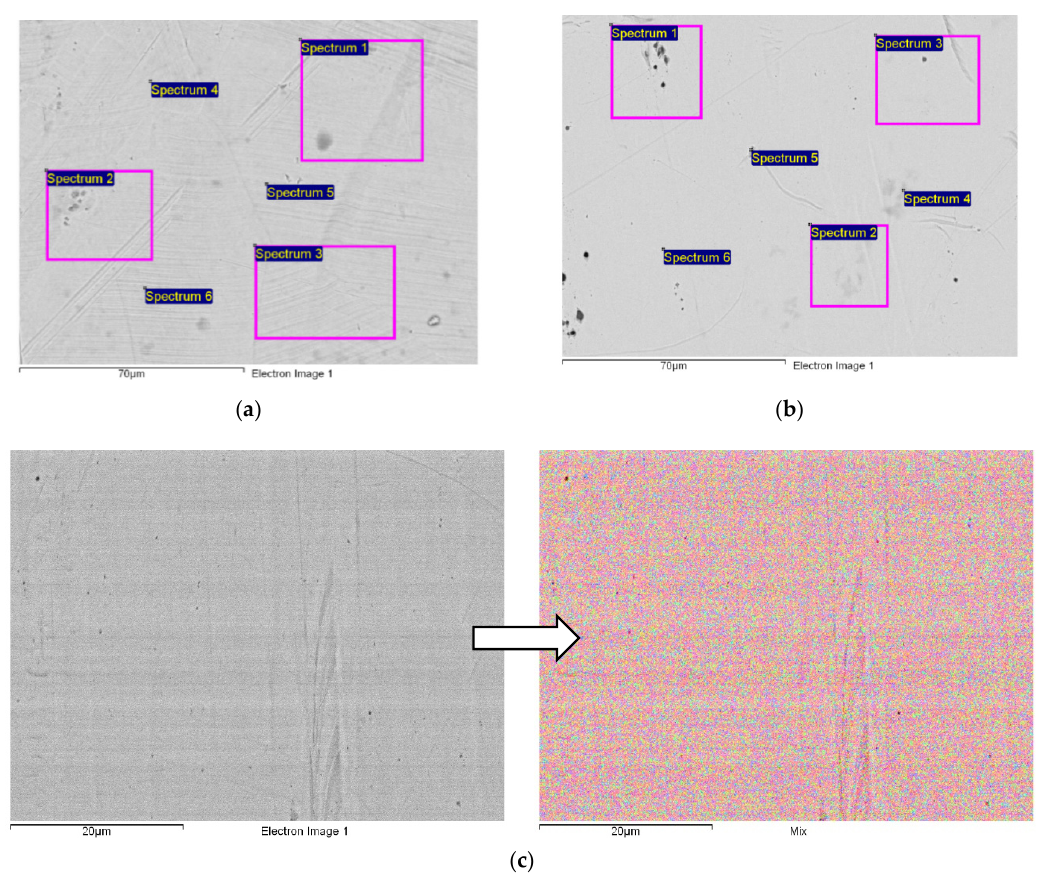
Figure 2. SEM micrographs of the AuCuZnGe alloy: ( a ) Before, ( b ) After corrosion testing, and ( c ) SEM/EDX mapping after corrosion testing with the constituent elements shown in different colors: Cu—red, Zn—green, Ge—blue, Au—purple. Table 1. Results of the micro-chemical EDS analysis: surface AuCuZnGe before corrosion testing (in wt.%).